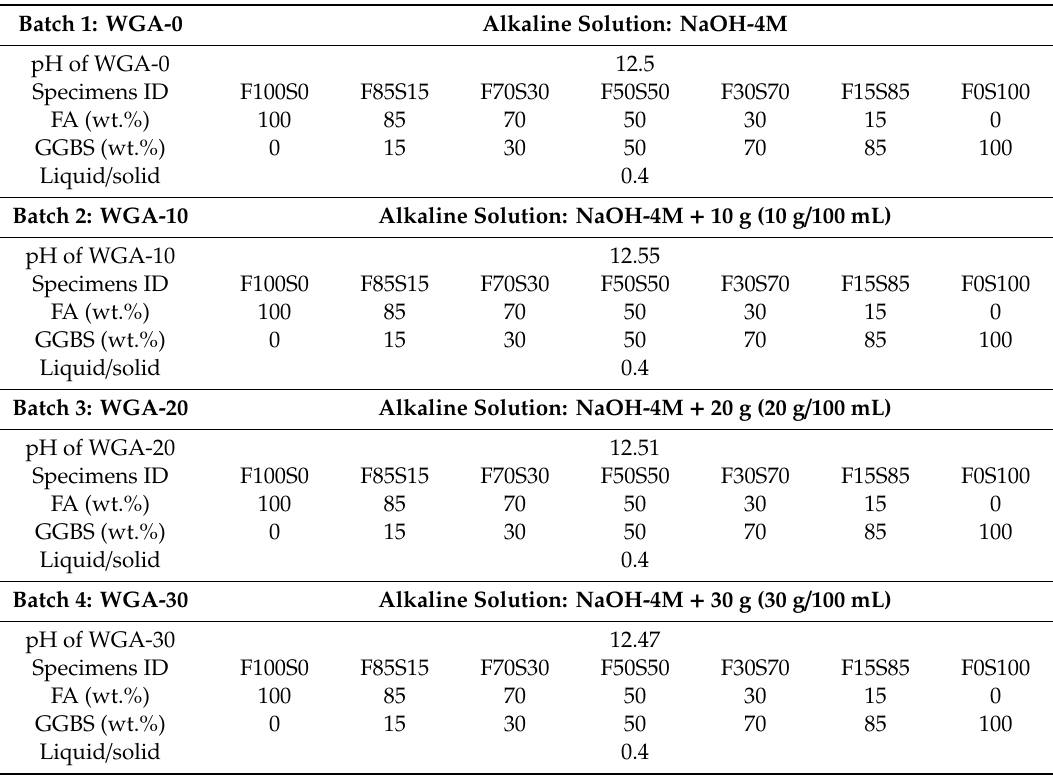
Table 2. Samples’ ID and mix